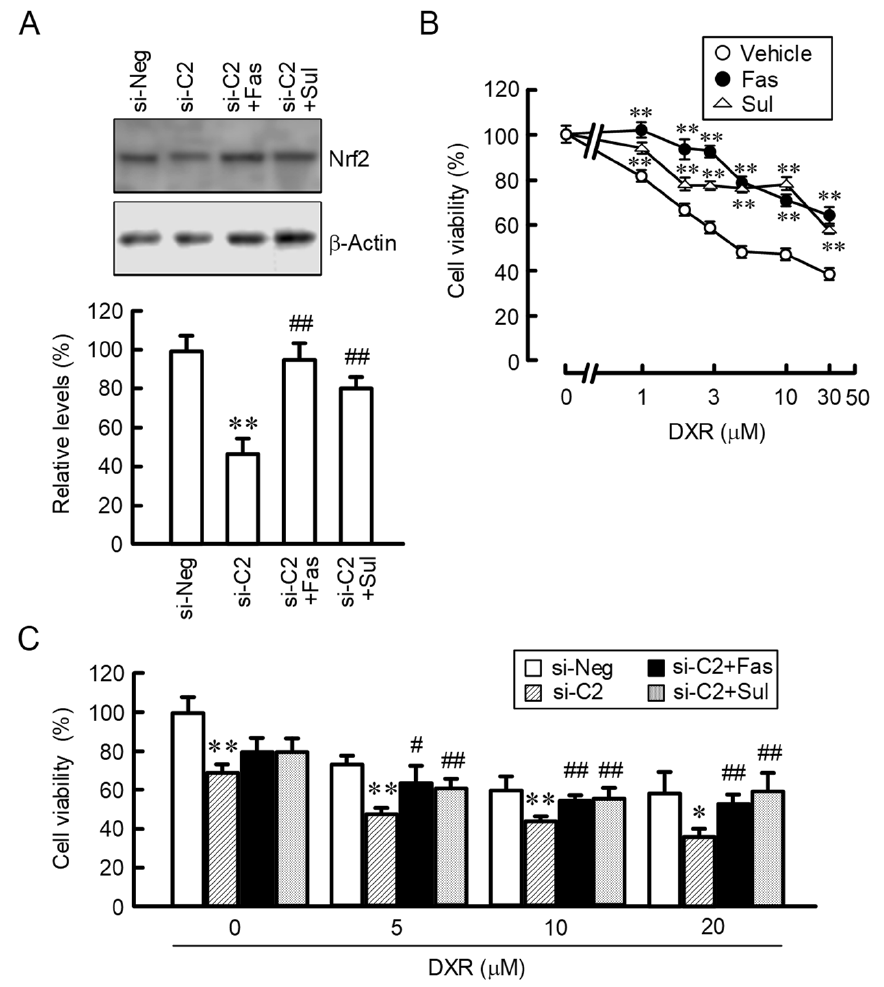
Figure 8. Inhibition of CLDN2 knockdown-induced chemosensitization by fasentin and sulforaphane. ( A ) A549 cells transfected with negative (si-Neg) or CLDN2 siRNA (si-C2) were cultured on 6 cm dishes for 3 days. Then, the cells were incubated in the absence and presence of 10 µ M fasentin (Fas) or 10 µ M sulforaphane (Sul) for 24 h. Western blotting was performed using anti-Nrf2, and anti- β -actin antibodies. The protein levels are represented relative to the values in si-Neg. ( B ) The cells transfected with si-C2 were cultured on 96-well plates for 3 days. Then, the cells were incubated in the absence (Vehicle) and presence of 10 µ M Fas, 10 µ M Sul, or DXR for 24 h. The cell viability was measured using the Premix WST-1 Cell Proliferation Assay System. ( C ) The cells transfected with si-Neg or si-C2 were cultured on 96 well round-bottomed plates for 3 days. Then, the cells were incubated in the absence and presence of 10 µ M Fas, 10 µ M Sul, or DXR for 24 h. The cell viability was measured using the CellTiter-Glo 3D Cell Viability Assay Kit. n = 3–4. ** p < 0.01 and * p < 0.05 compared with si ‐ Neg or vehicle. ## p < 0.01 and # p < 0.05 compared with si ‐ C2 alone.